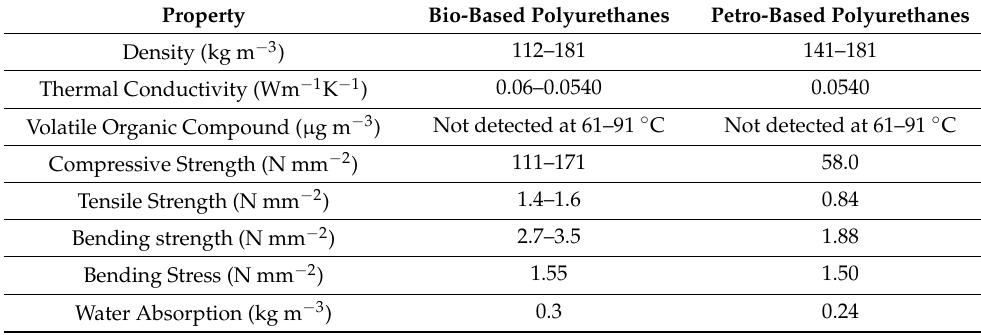
Table 2. Comparison of the Properties of Bio-Based Polyurethane and Petro-Based Polyurethane [16].